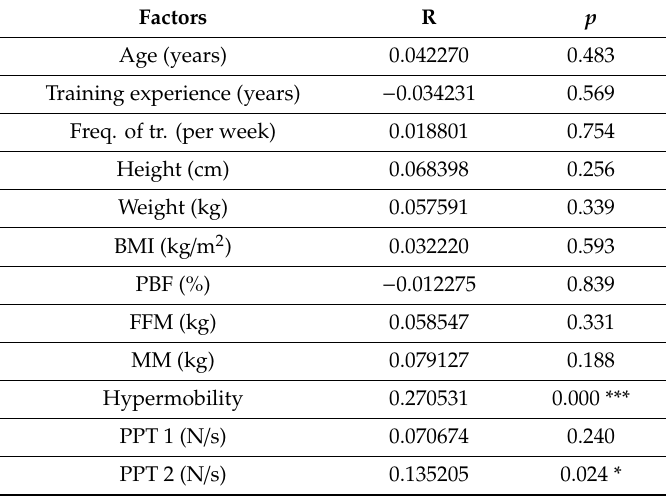
Table 2. Spearman’s rank correlation coe ffi